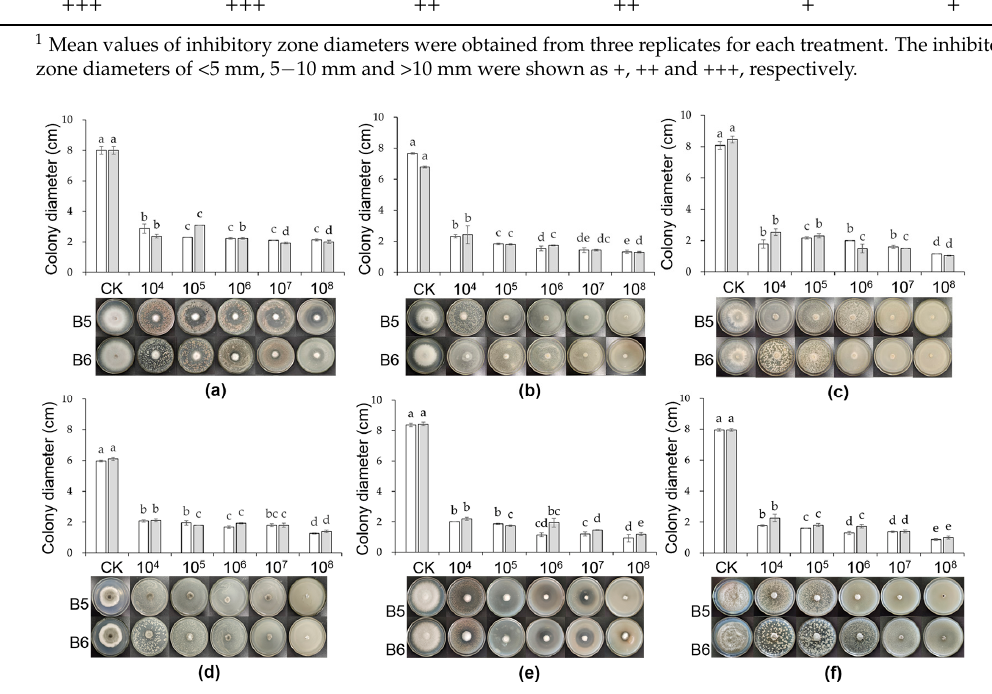
Table 1. Antifungal activity of B5 and B6 against different pathogens in vitro. Inhibition Effects 1